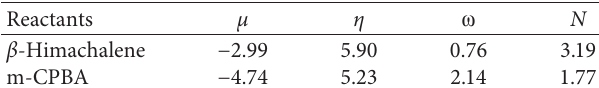
Table 1: Electronic chemical potential ( μ ), chemical hardness ( η ), electrophilicity ( ω ), and nucleophilicity ( N ) of β -himachalene and m-CPBA